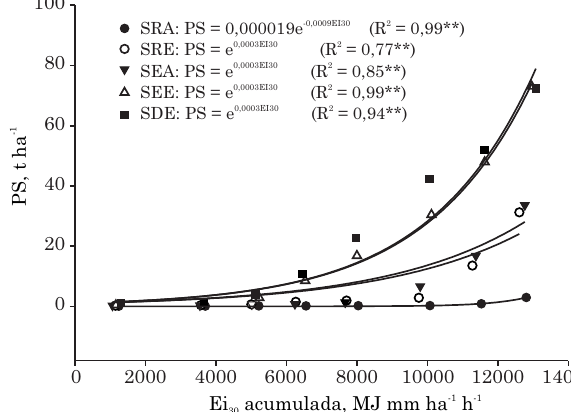
Figura 3. Relação das perdas de solo por erosão hídrica, PS, e o índice de erosividade das chuvas, EI 30 , em diferentes manejos do solo. SRA: solo coberto por resíduo de azevém; SRE: solo coberto por resíduo de ervilhaca; SEA: solo escarificado com raiz de azevém; SEE: solo escarificado com raiz de ervilhaca; e SDE: solo descoberto escarificado.